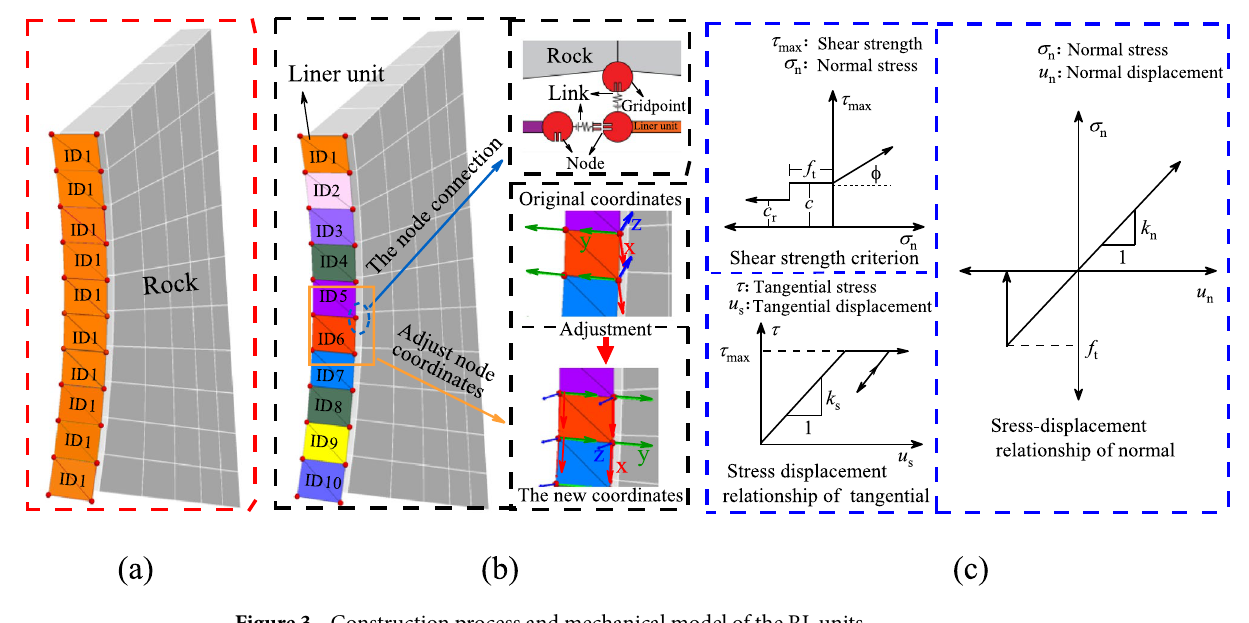
Figure 3. Construction process and mechanical model of the RL